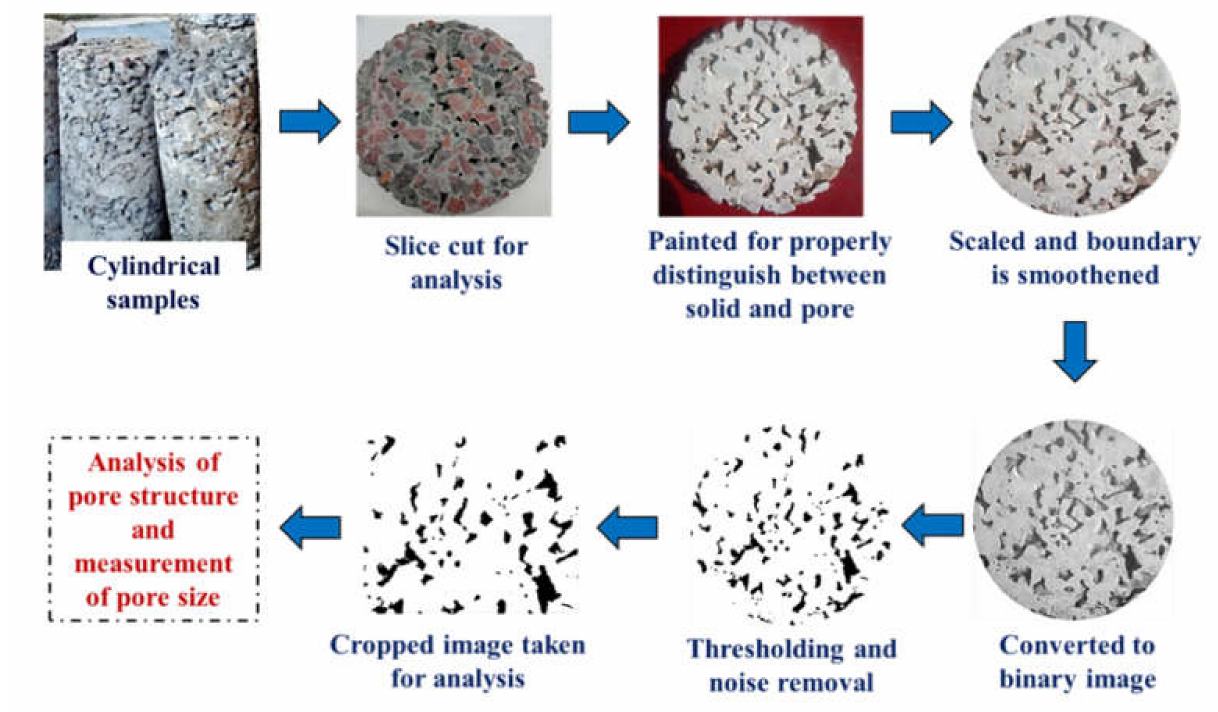
Figure 3. Method of image